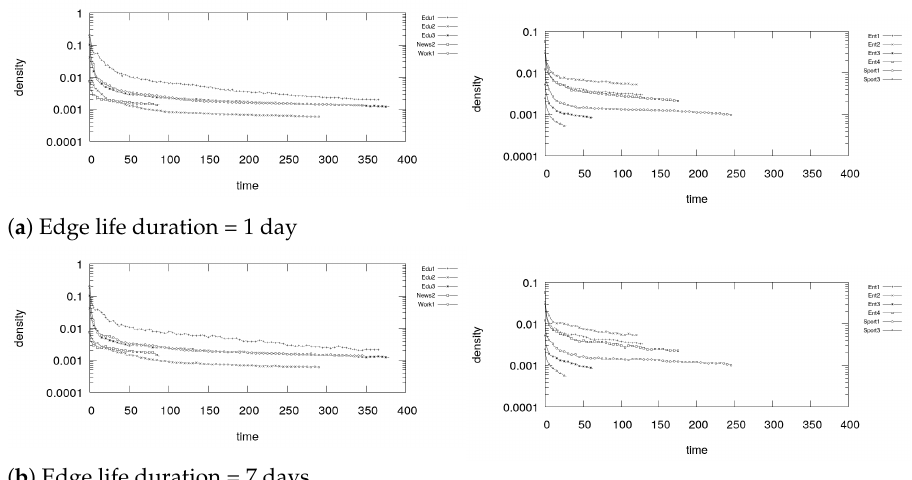
Figure 32. Internal density of communities detected by K-core.